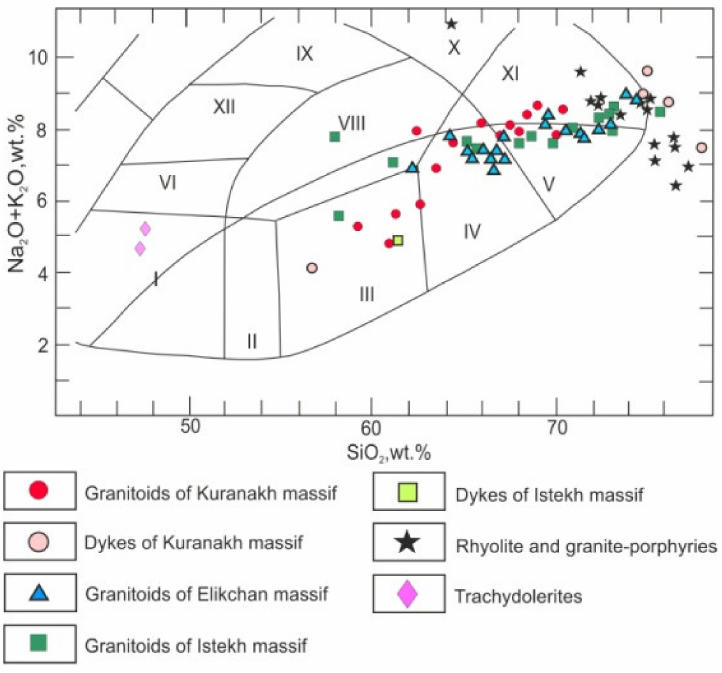
Figure 7. SiO 2 –(Na 2 O + K 2 O) diagram for magmatic rocks. Fields on the diagram [77]: I—gabbro; II—gabbro–diorite; III—diorite, IV—granodiorite, V—granite; VI—subalkaline gabbro; VII–VIII— monzonite; IX–X—syenite; and XI—alkali granite.